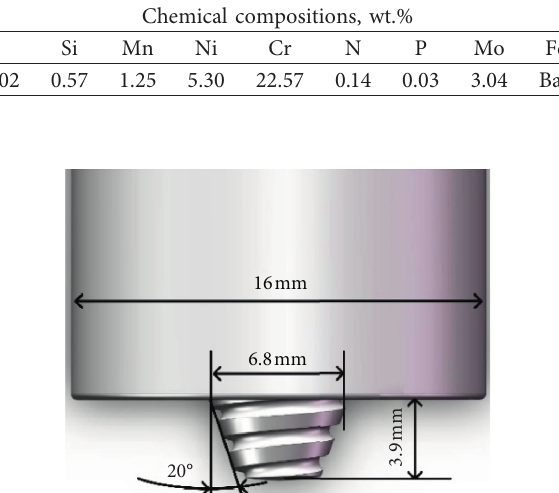
Figure 1: Schematic of welding